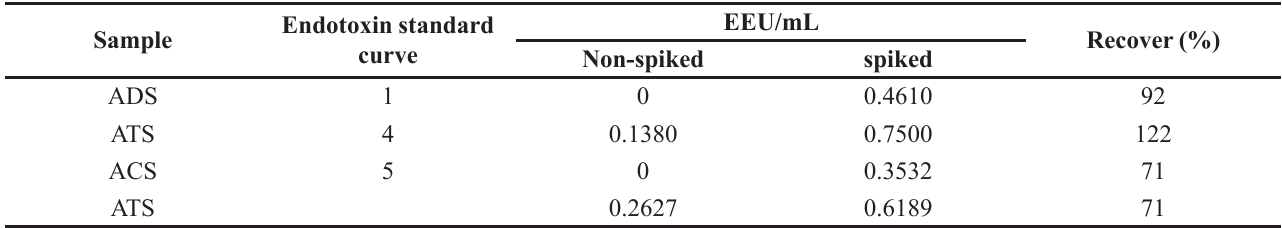
TABLE II - Results for MAT performed with Cryoblood transported and stored under monitored and controlled conditions. The results for equivalent endotoxin and recovery rates are averages of quadruplicates. Samples were diluted 1/10 and the represented values are average of quadruplicates. ATS: tetanus antiserum; ADS: diphtheria antiserum; ACS: crotalus